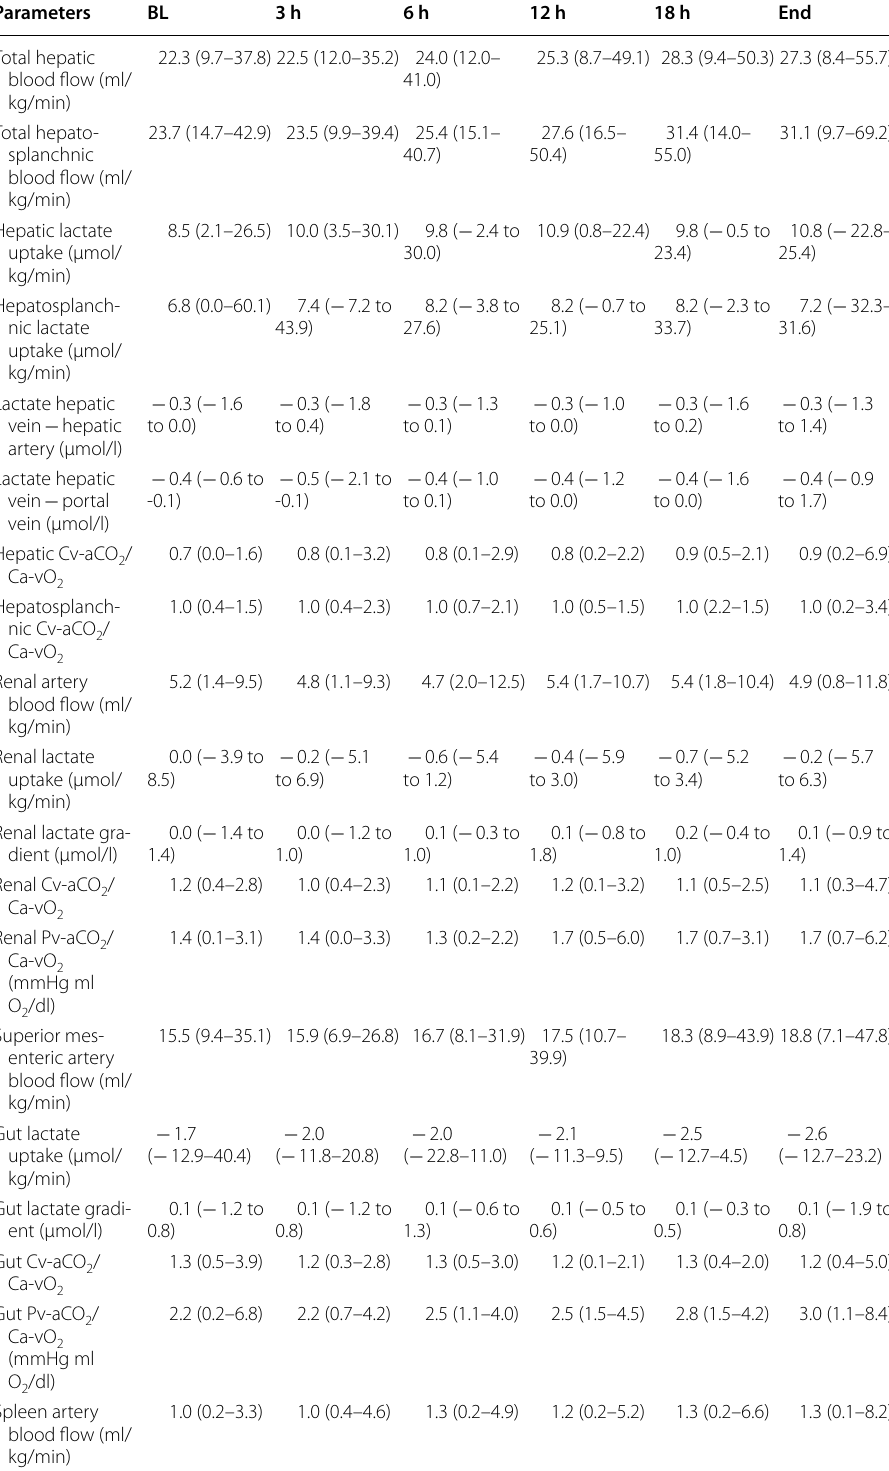
Table 3 Regional blood flow, lactate uptake and venous–arterial CO content difference